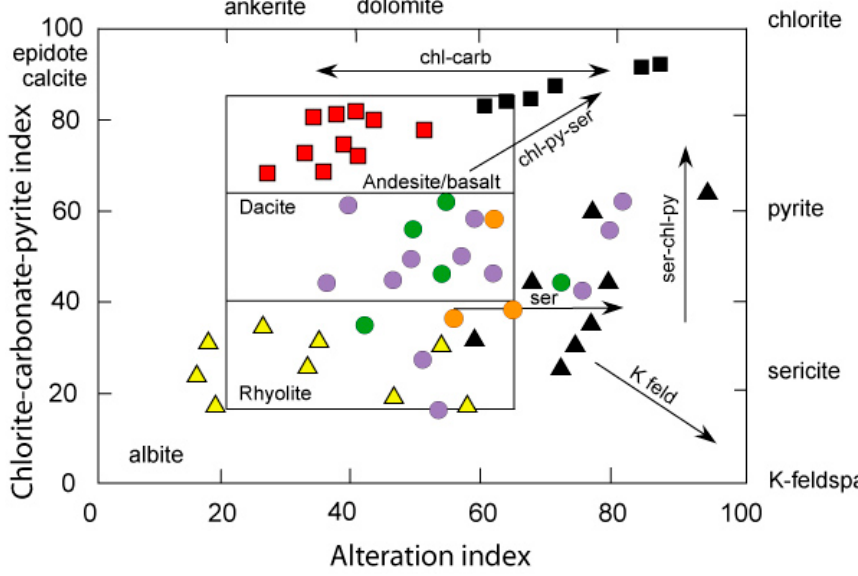
Figure 10. Alteration box diagram [45] showing hydrothermal alteration trends (solid arrows) in relation to unaltered felsic, intermediate and mafic igneous rocks (inset box). Bimodal supracrustal metavolcanic rocks proximal to magnetite deposits in the New Jersey Highlands plot along a trend characterized by moderate to severe chlorite-pyrite-sericite hydrothermal alteration, whereas metavolcanic rocks distal to the deposits are relatively unaltered [33,41]. Biotite gneiss plots mainly in the field of unaltered rocks, although five samples, including one each from Ringwood and Mase Mountain, show incipient alteration along the same trend as altered metavolcanic rocks. Red and black squares are unaltered and altered mafic metavolcanic rocks, respectively; yellow and black triangles are unaltered and altered felsic metavolcanic rocks, respectively Other symbols as in Figure 5. AI = 100(K 2 O + MgO)/(K 2 O + MgO + Na 2 O + CaO). CCPI = 100(MgO + FeO*)/(MgO + FeO* + Na 2 O + K 2 O).